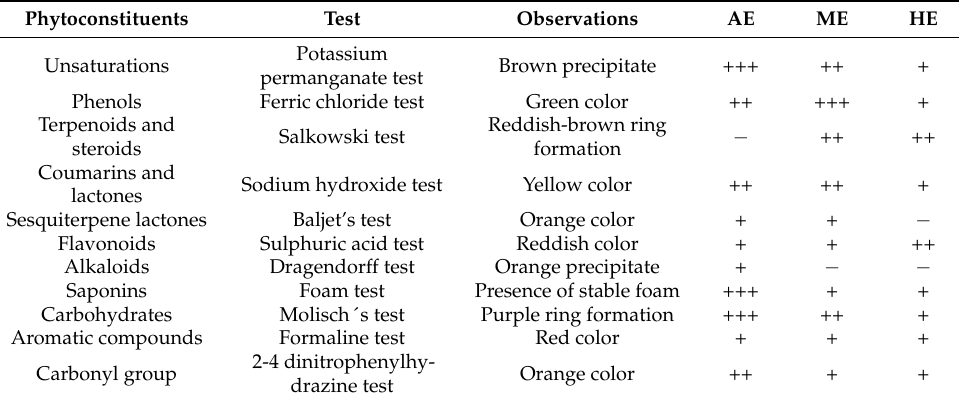
Table 1. Partial phytochemical screening of the crude extracts of A. monostachya . Phytoconstituents Test Observations Unsaturations Reddish-brown ring Salkowski test steroids formation Coumarins and Sodium hydroxide test lactones Sesquiterpene lactones Baljet’s test Dragendorff test Foam